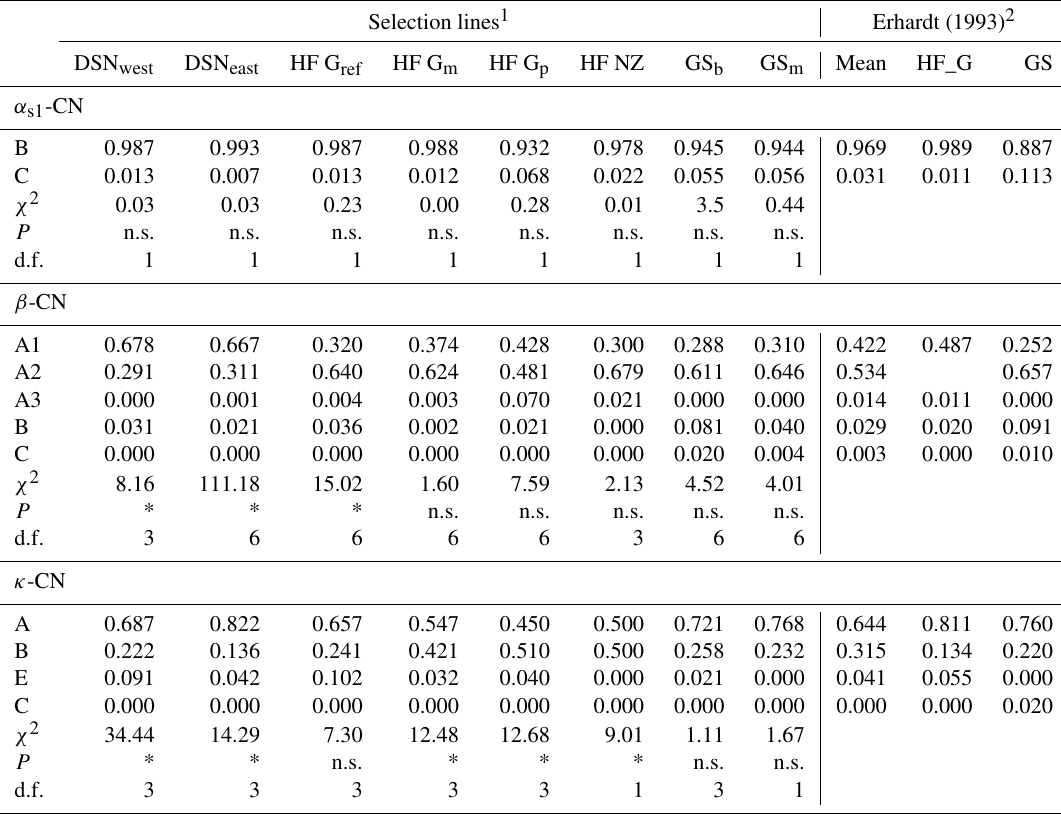
1 Abbreviations for selection lines are given in Table 1. 2 For comparisons of present results with historic data, allele frequencies of the HF_G and GS breeds from the study by Erhardt (1993) were considered.